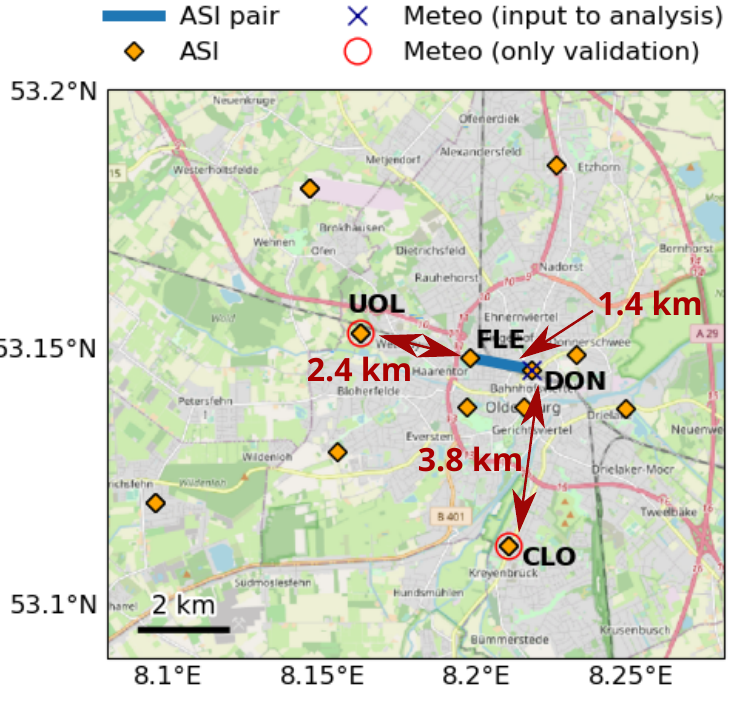
Figure 1. This map gives an overview of the Eye2Sky all-sky imager (ASI) network in the urban area of Oldenburg. ASIs are shown which were operational in 2020 (orange diamonds). The ASI pair uses the ASI stations DON and FLE and is marked with a blue line. The rotating shadowband irradiometer (RSI) at DON ( × ) provides input data to the analysis approaches (ASI network, ASI pair, and homogeneous persistence). The RSIs at stations UOL in the west and CLO in the south are only used for validations ( ◦ ). (background: © OpenStreetMap contributors 2022. Distributed under a Creative Commons BY-SA